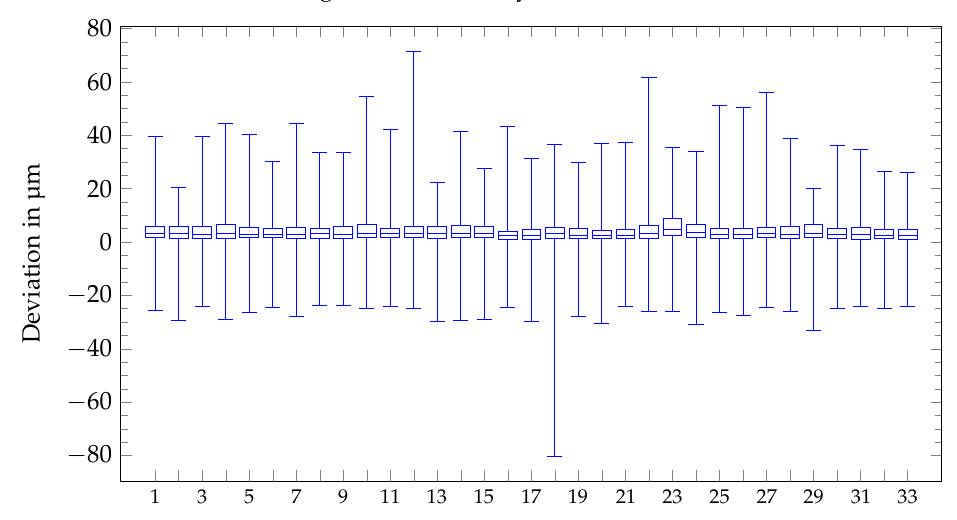
Figure 10. Box plots of the deviation analysis for the L-angle particle.